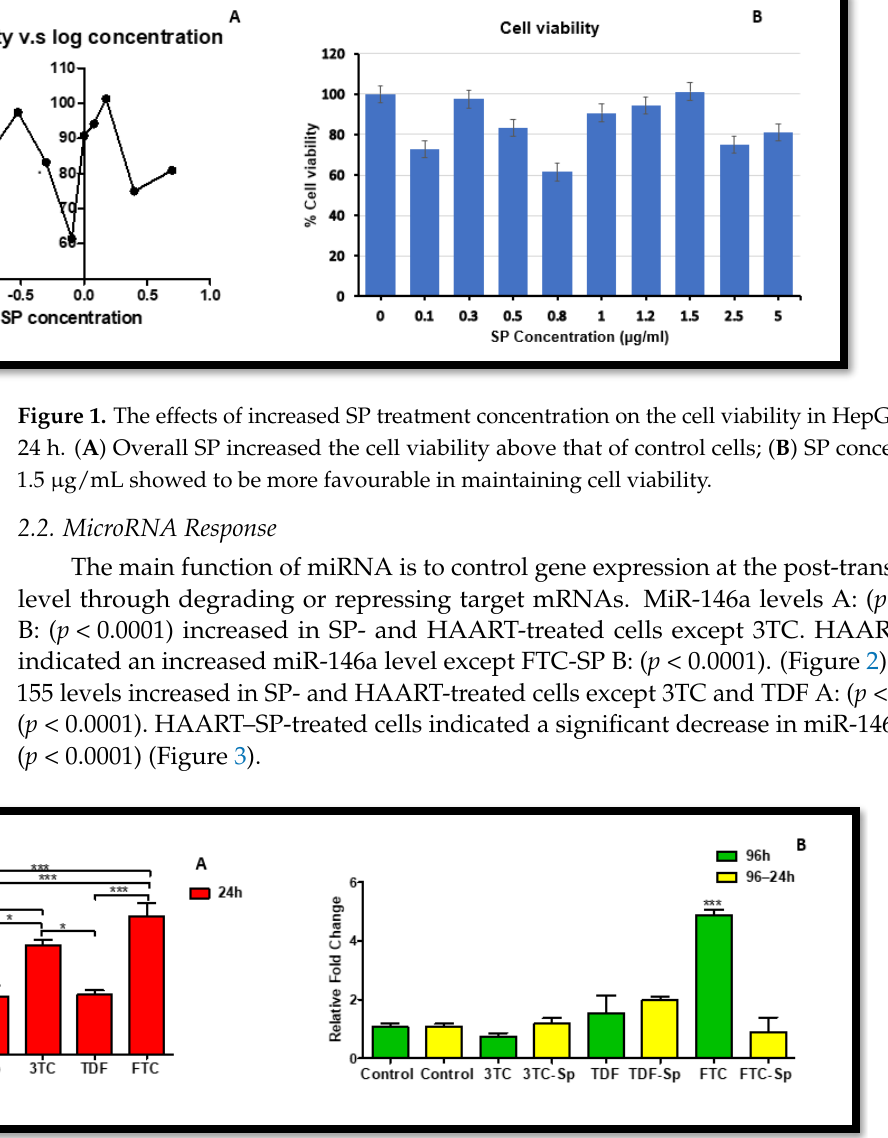
Figure 2. Effects of SP and HAART (3TC, TDF, and FTC) on MiR-146a levels. MiR-146a levels after exposure of HepG2 cells to ( A ) SP and HAART for 24 h, ( B ) HAART (96 h), and HAART (96 h) followed by SP (24 h); * p < 0.05, *** p < 0.0001 .